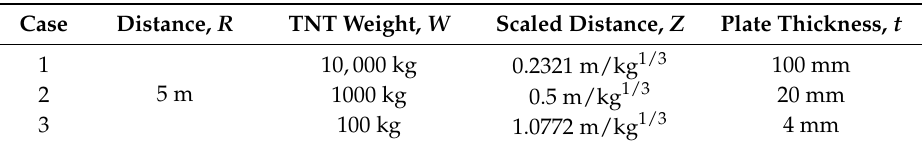
Table 8. Blast Load Conditions for Simulations.